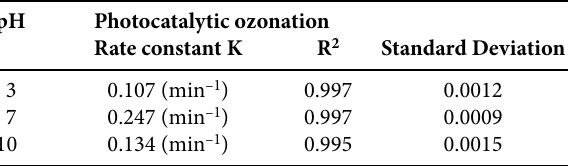
Table 1: Rate constant of imazapyr degradation with photocatalytic ozonation for different pH.